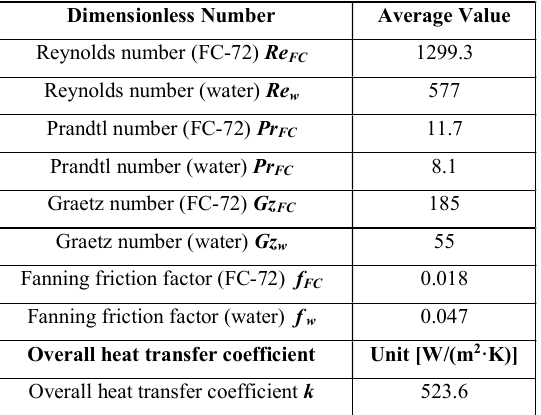
Table 3. Values of selected dimensionless numbers, Fanning friction factors and the overall heat transfer coefficient. Dimensionless